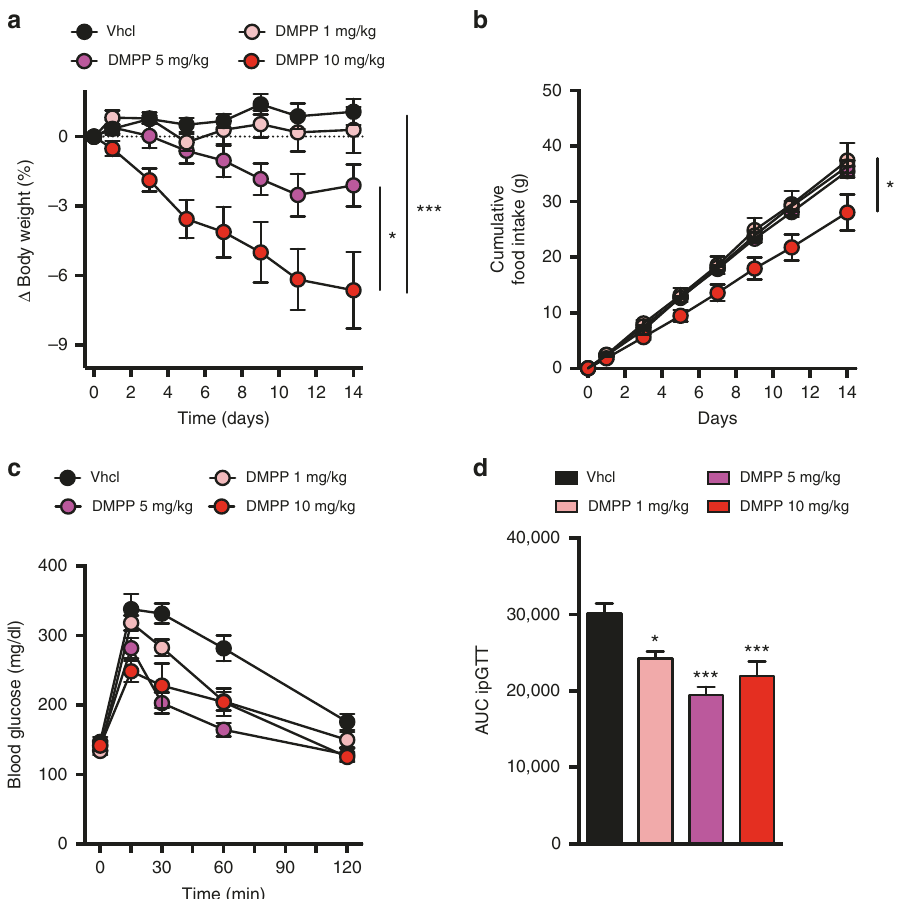
Fig. 2 The nicotinic receptor agonist DMPP lowers body weight and improves glucose tolerance in DIO mice. a Effects on body weight, b food intake, and c , d glucose tolerance following daily s.c. injections to DIO male C57Bl6j mice of vehicle (black, n = 8 for a , b ; n = 7 for c , d ), DMPP 1 mg/kg (light red, n = 8), DMPP 5 mg/kg (pink, n = 7 for a , b ; n = 8 for c , d ), and DMPP 10 mg/kg (dark red, n = 7) for 14 days. * p < 0.05, *** p < 0.001 by two-way ANOVA ( a , b , c ) and one-way ANOVA with Tukey post-hoc test ( d ). All data are presented as mean ±